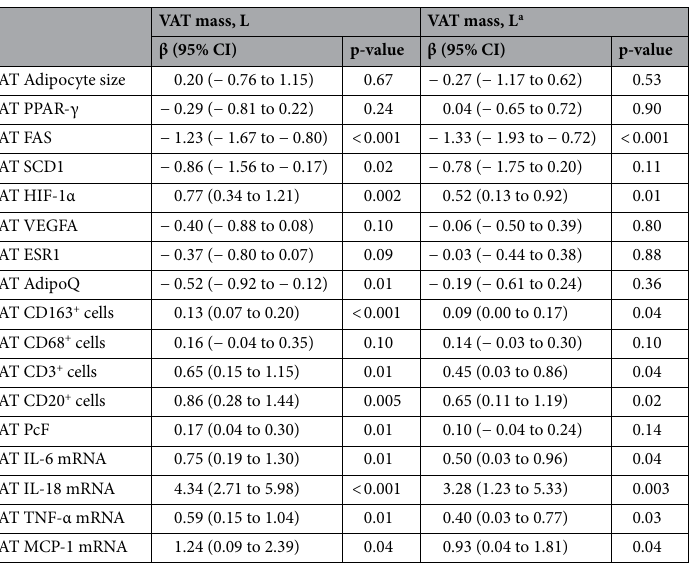
Table 2. Subcutaneous adipose tissue inflammation and morphology associated with visceral adipose tissue mass. SAT subcutaneous adipose tissue, VAT visceral adipose tissue, PPAR Peroxisome proliferator activated receptor, FAS fatty-acid synthase, SCD Stearoyl-CoA desaturase, HIF Hypoxia-inducible factor, VEGFA vascular endothelial growth factor, ESR1 estrogen receptor 1, AdipoQ adiponectin, CD cluster of differentiation, PcF pericellular fibrosis, IL interleukin, TNF tumor necrosis factor, MCP Monocyte Chemoattractant Protein. N = 26. a Model corrected for total fat mass.